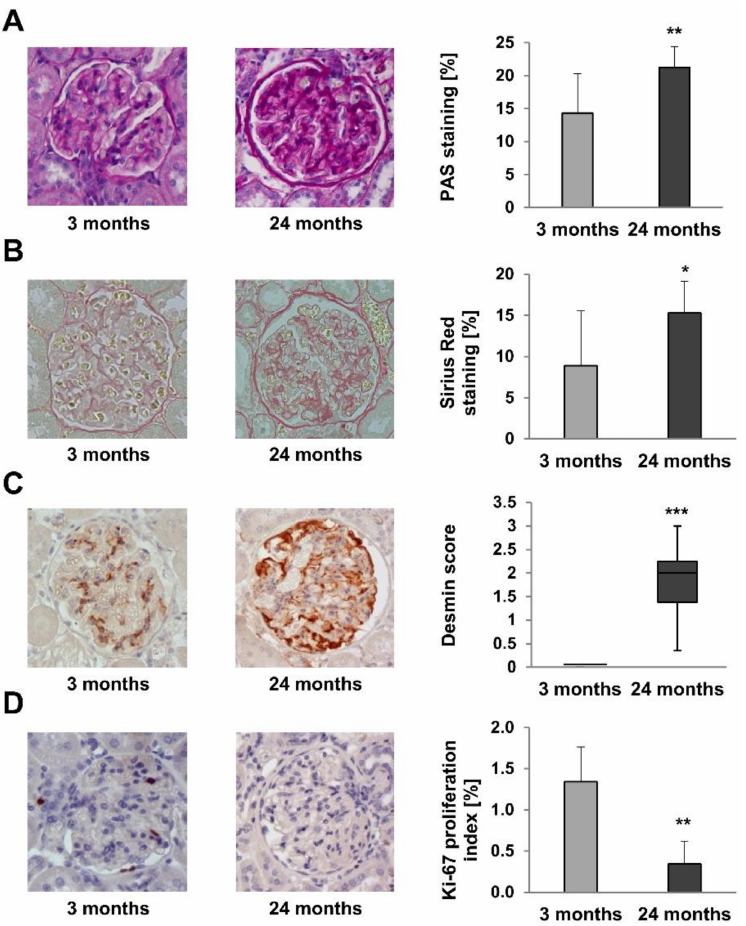
Figure 4. Histomorphometric analyses on kidney sections of 3- and 24-month-old rats. ( A ) PAS- positive areas were significantly increased in 24-month-old rats ( p = 0.007). ( B ) Sirius Red staining of collagen, was significantly increased in 24-month-old rats ( p = 0.033). ( C ) Glomerular desmin staining was significantly increased in 24-month-old rats ( p = 0.001). ( D ) The proportion of Ki-67-positive proliferating glomerular cells was significantly reduced in 24-month-old rats ( p = 0.002). For all Figures p -values ≤ 0.05, ≤ 0.01, and ≤ 0.001 are indicated by one, two or three asterisks, respectively. Magnification